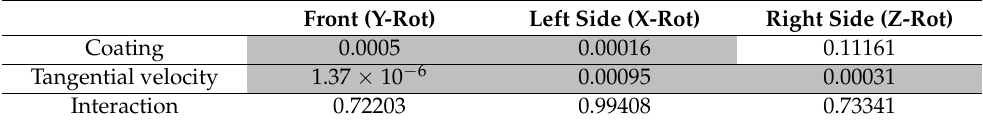
Figure 13. Resultant angular acceleration for the right side impacts. Solid lines correspond to covered headform and dashed lines correspond to bare headform test. Table 2. Two-way ANOVA results ( p -values) for the PLA. p -values < 0.05 portrayed as shaded cells.